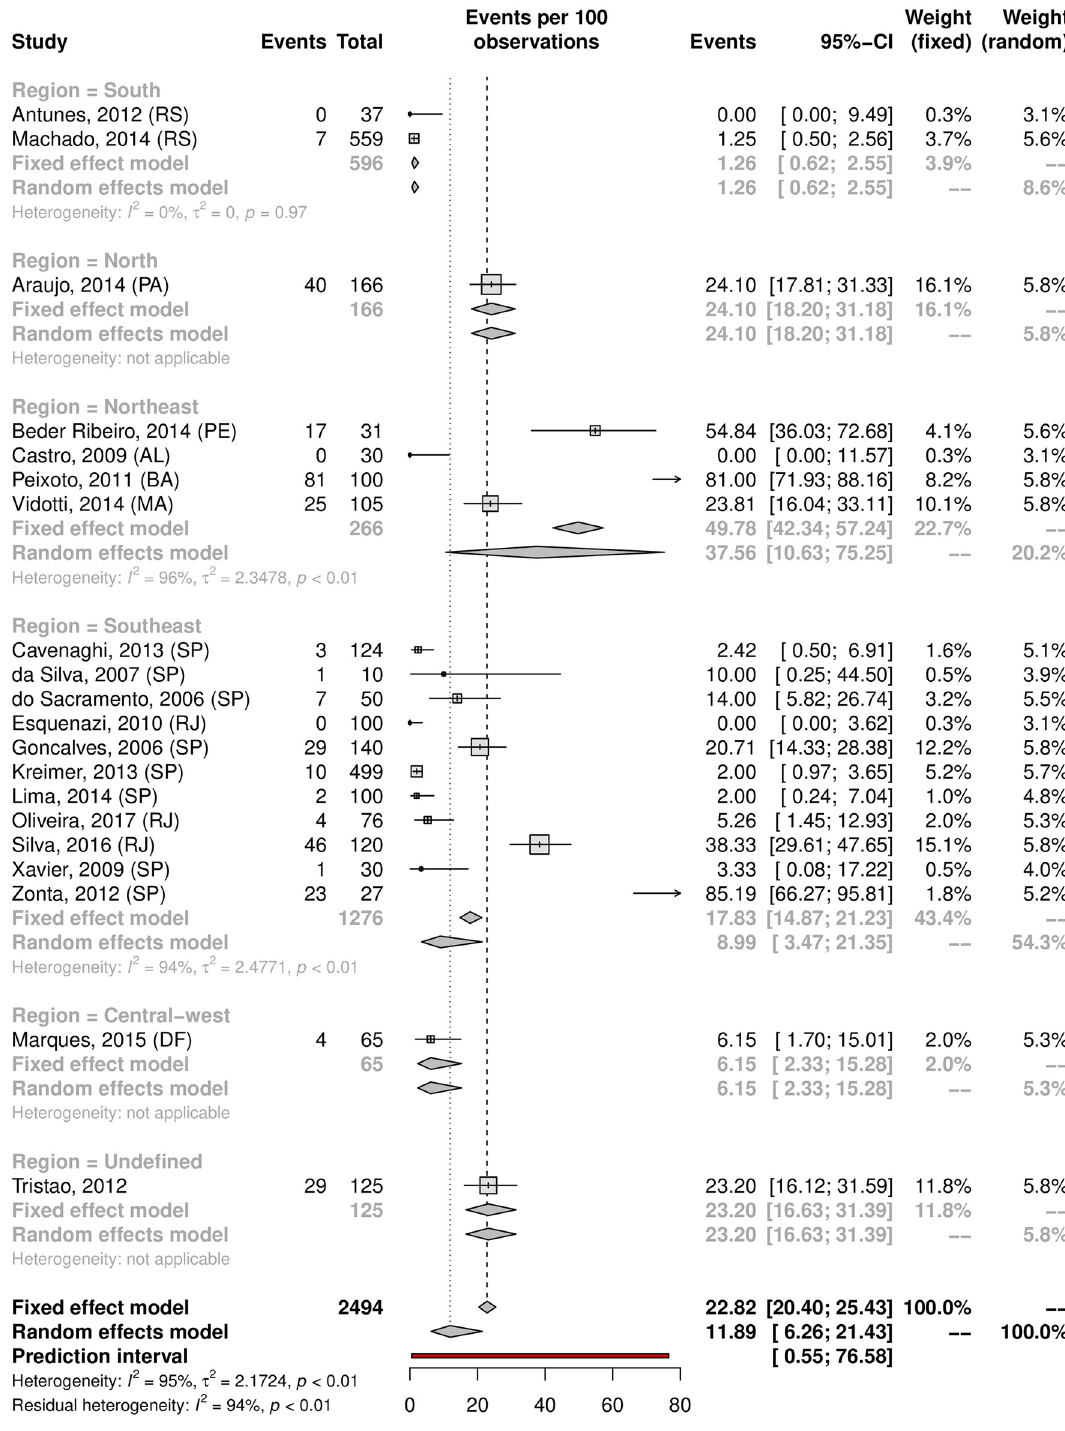
PLOS ONE | https://doi.org/10.1371/journal.pone.0229154 February 21,